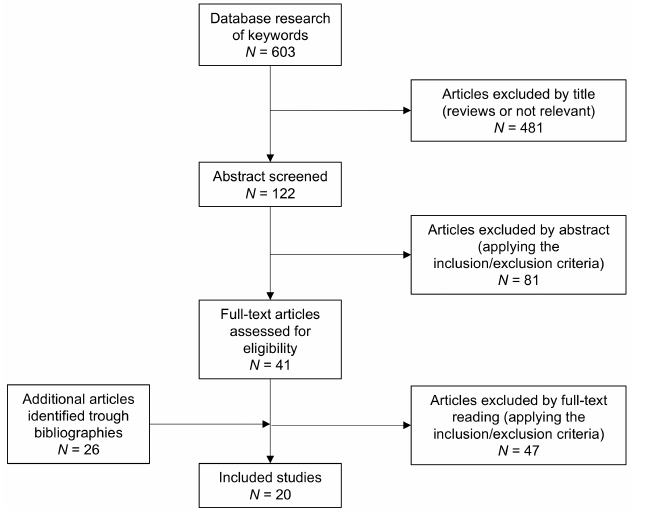
Figure 1. Flowchart of studies disposition throughout the search and article selection process according to PRISMA guidelines for scoping reviews